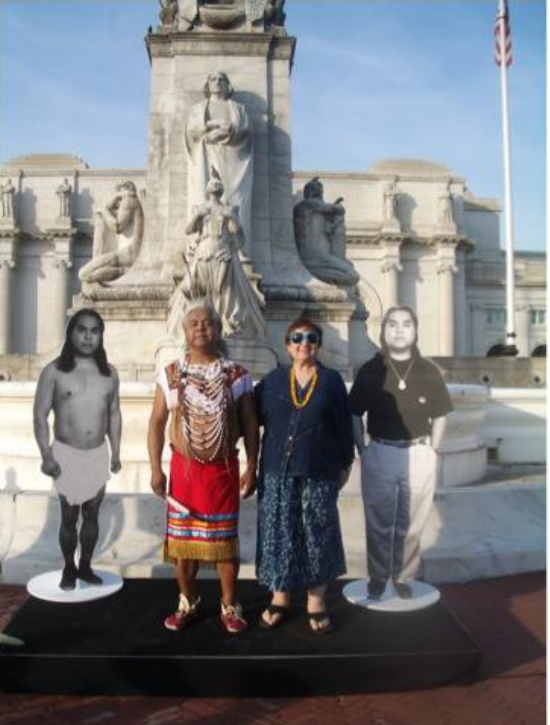
James Luna, Take a Picture with a